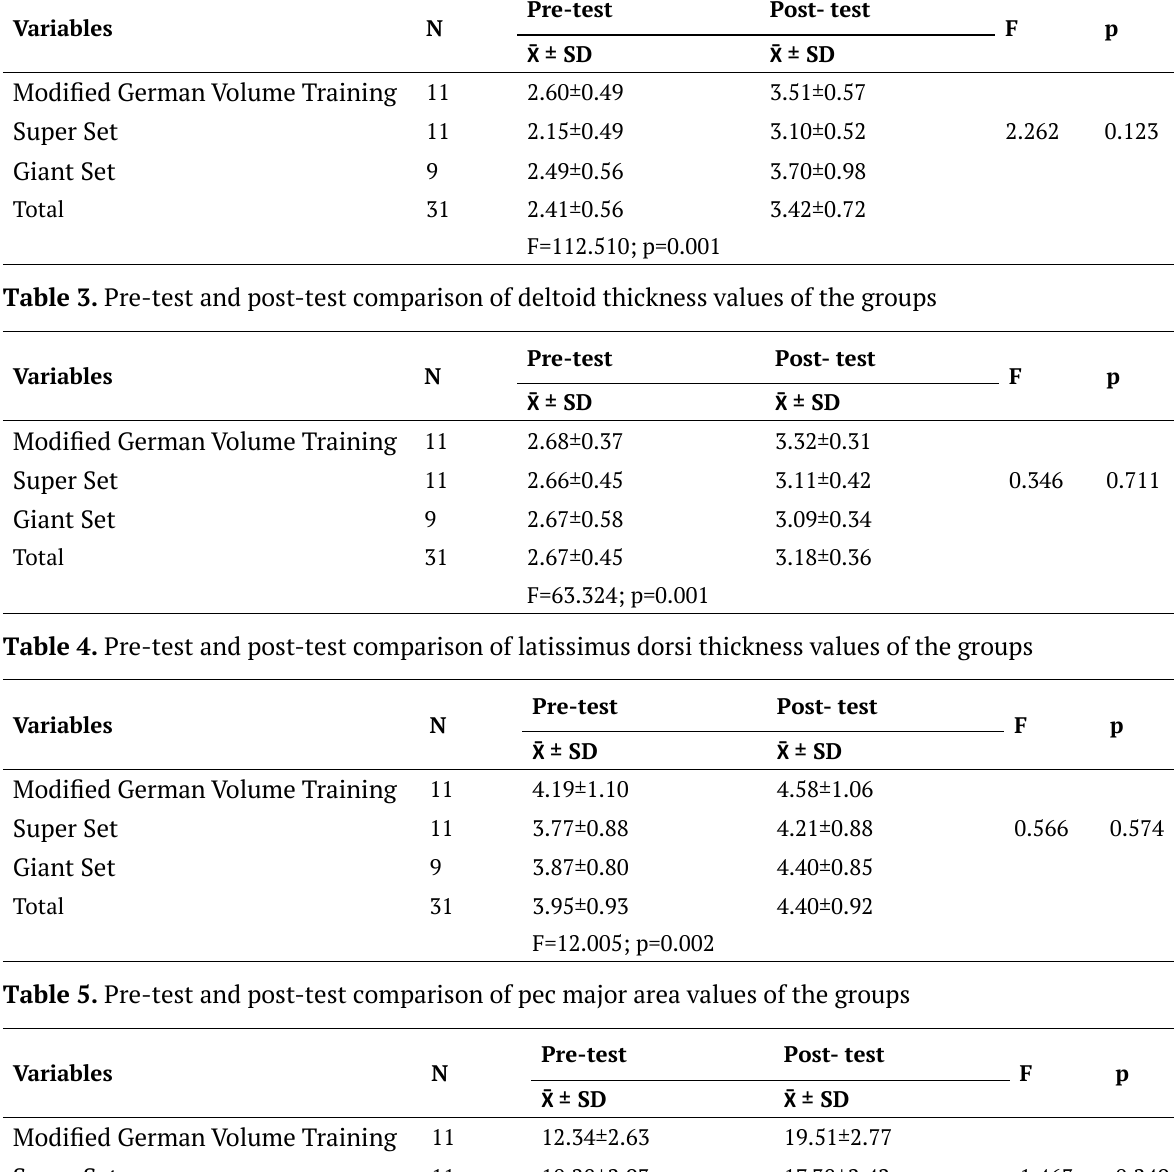
Table 2. Pre-test and post-test comparison of pec major thickness values of the groups Variables